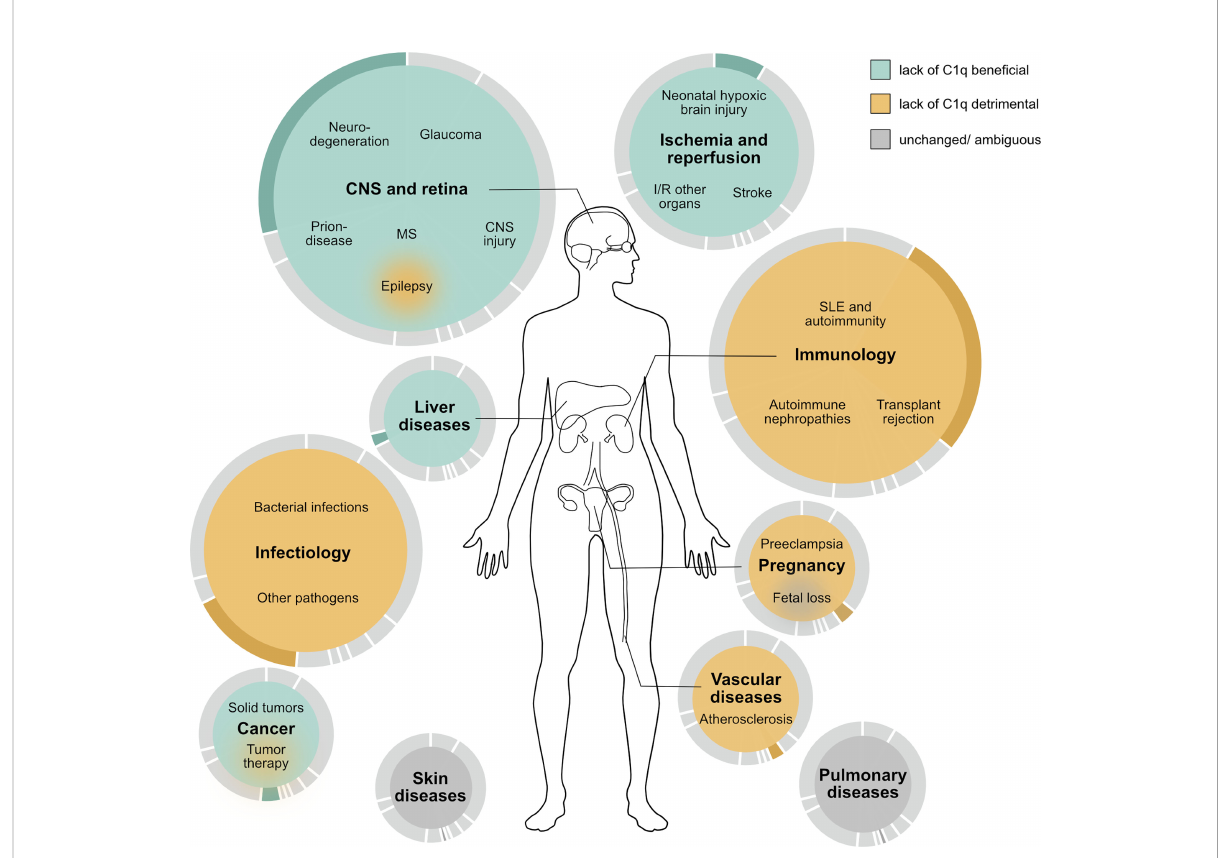
FIGURE 2 Schematic overview of the proposed effect of C1q de fi ciency on human disease based on the outcome of studies performed in murine disease models. Bene fi cial effects are colored in turquoise, detrimental in ocher, and outcomes without general trend or with ambiguous results in grey. The size of the colored area and the underlying pie chart illustrate the number of studies performed in the respective area. MS multiple sclerosis, I/R ischemia and reperfusion, SLE systemic lupus